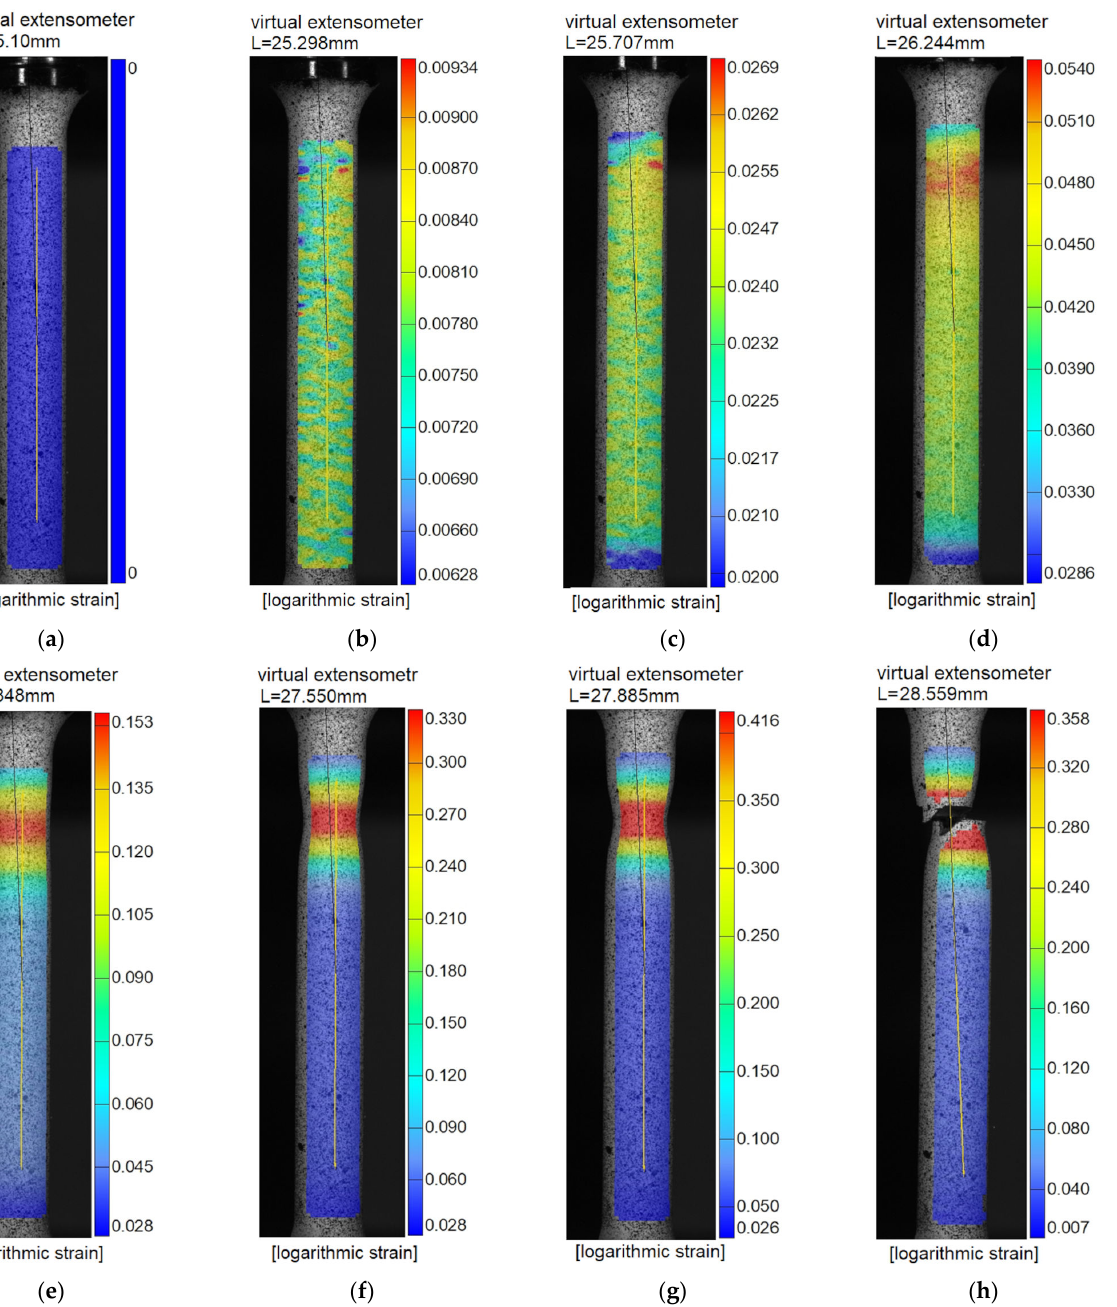
Figure 9. Stage photos recorded with DIC method: ( a ) stage 0—unloaded specimen; ( b ) stage 50; ( c ) stage 100; ( d ) stage 150; ( e ) stage 200; ( f ) stage 250; ( g ) stage 272—prior to separation; ( h ) stage 273 (after fracture).